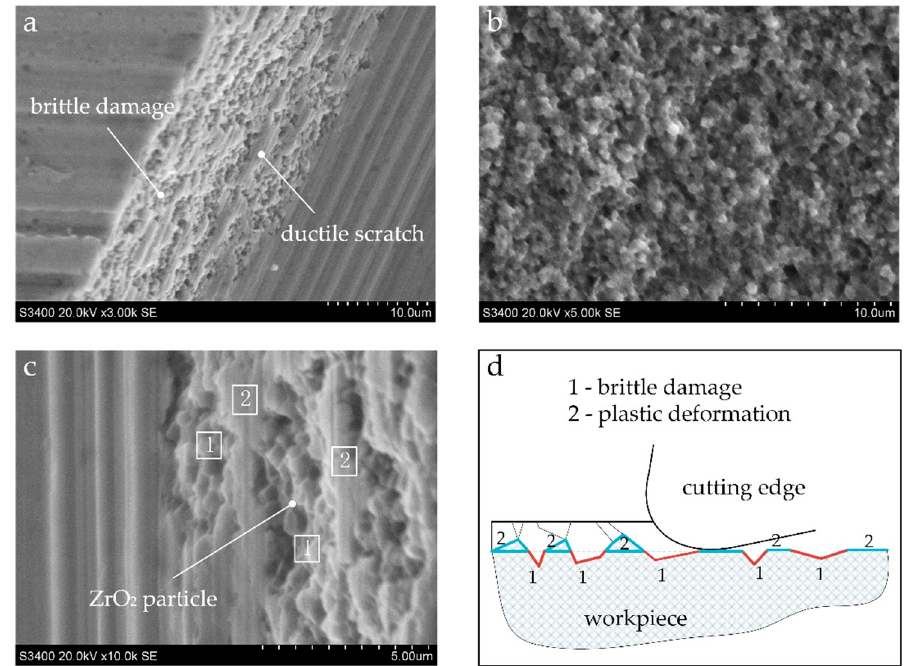
Figure 11. SEM image of ( a ) brittle fracture and plastic deformation in groove edge; ( b ) natural fracture surface of zirconia; ( c ) subtle view of micro damaged area and plastic scratched area; ( d ) schematic sketch of the material removal mechanism.